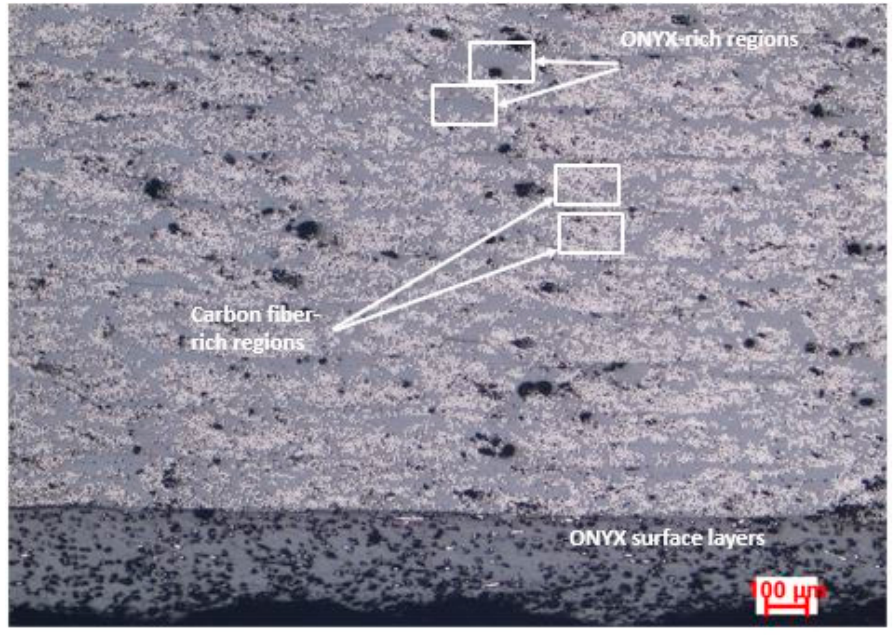
Figure 11. ONYX_R flexural tested sample cross section. Table 5. Maximum flexural strength